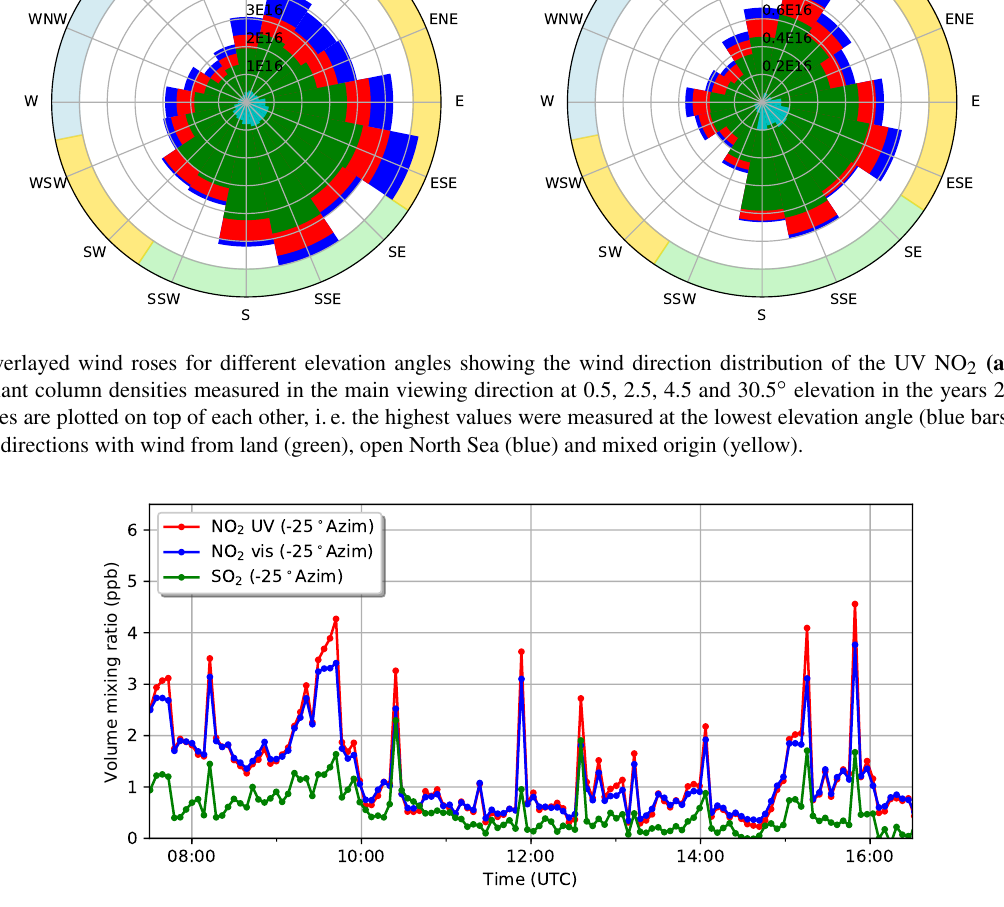
Figure 8. NO 2 (UV and visible) and SO 2 path-averaged volume mixing ratios measured at an 0.5 ◦ elevation angle and − 25 ◦ viewing azimuth angle (approximately NNW direction) on Neuwerk on 23 July